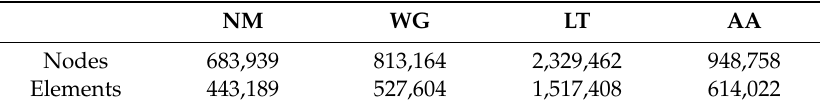
Table 2. The number of elements and nodes of each experimental group.